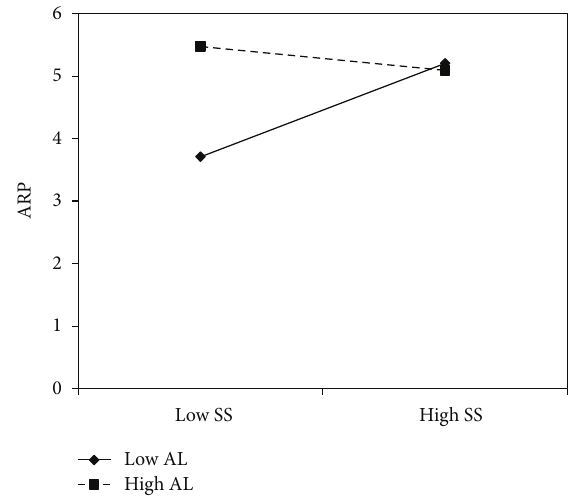
F 4: Anger lability moderated the effect of sensation seeking on alcohol-related problems among college